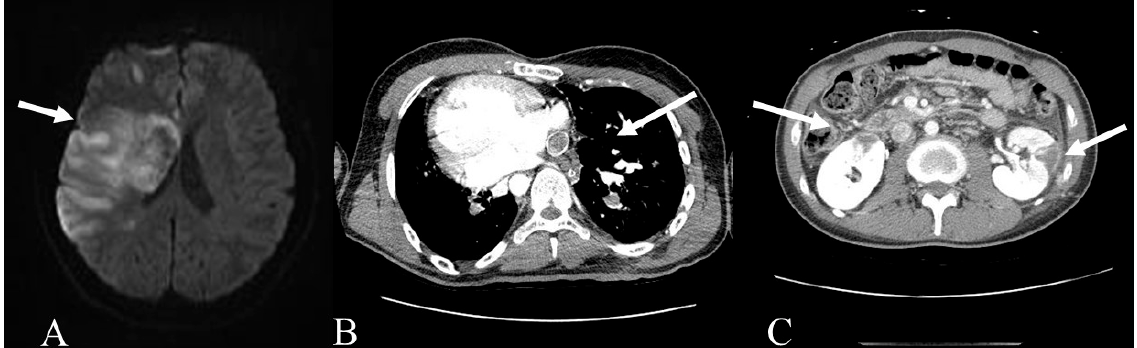
Figure 1. Multiple embolic events occurred in our patient, including ( A ) acute right middle cerebral artery territory infarction on magnetic resonance imaging, ( B ) pulmonary thromboembolism, and ( C ) multifocal renal infarctions on computed tomography.